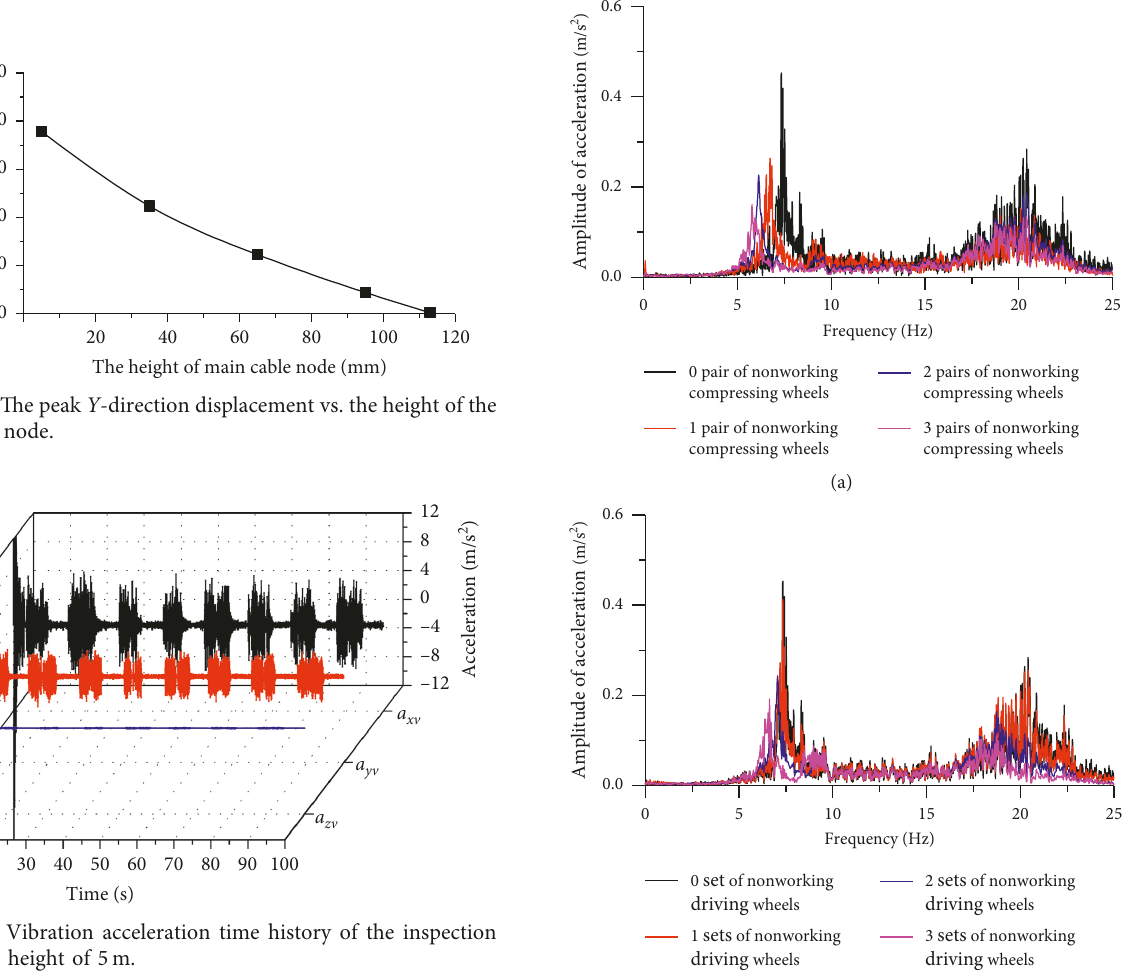
Figure 10: Vibration displacement time history of the node 5m above the main cable.